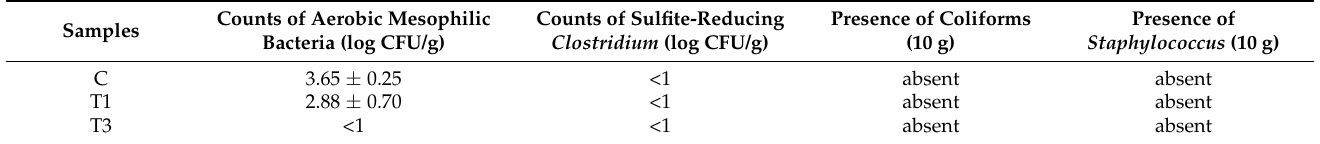
Table 3. Microbiological analysis of meatloaf with turmeric addition on the 21st day of refrigerated storage. Counts of Aerobic Mesophilic Counts of Sulfite-Reducing Samples Clostridium (log CFU/g) Bacteria (log CFU/g)